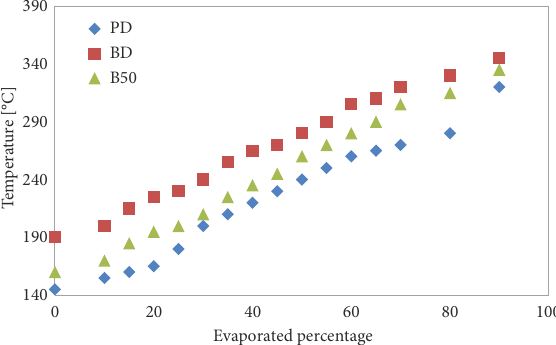
Figure 10. The distillation curves of PD, BD and B 50